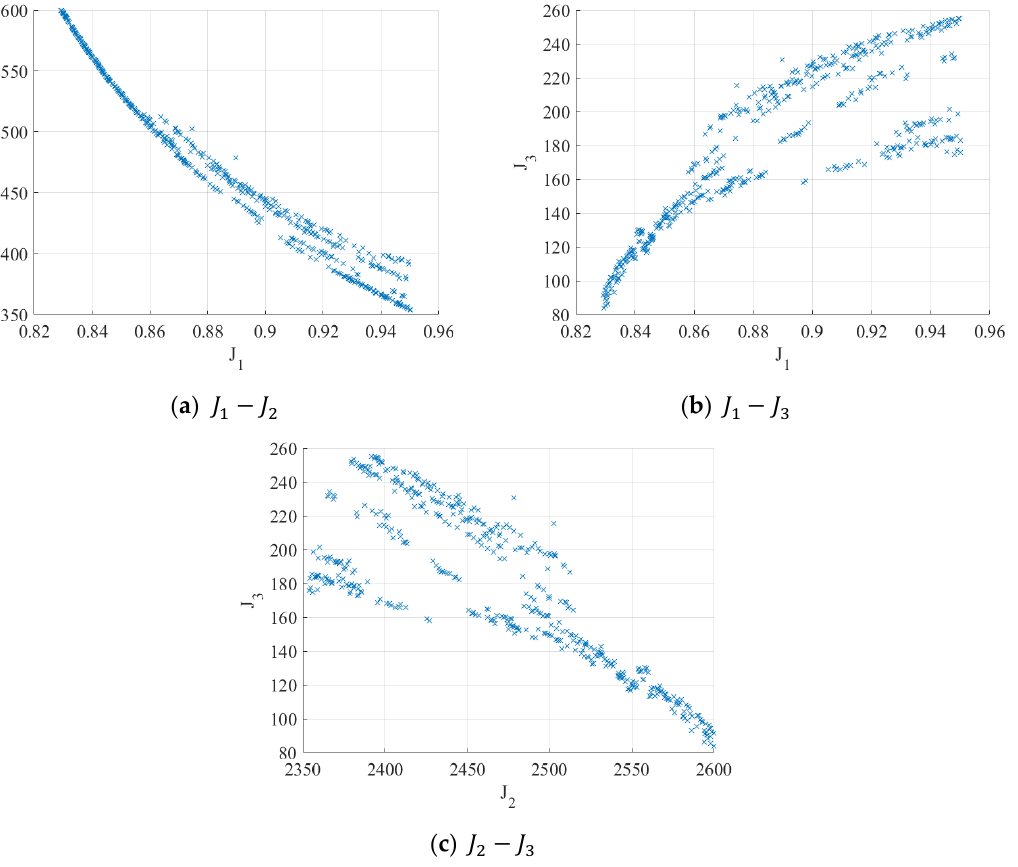
Figure 10. The 2D projection of the Pareto front ( a ) Pareto front of ride comfort and road holding; ( b ) Pareto front of ride comfort and energy-harvesting power; ( c ) Pareto front of road holding and energy-harvesting power.